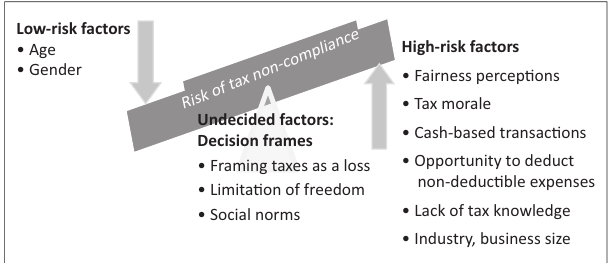
FIGURE 2: A profile of factors posing a risk for the compliance behaviour of guest house owners in